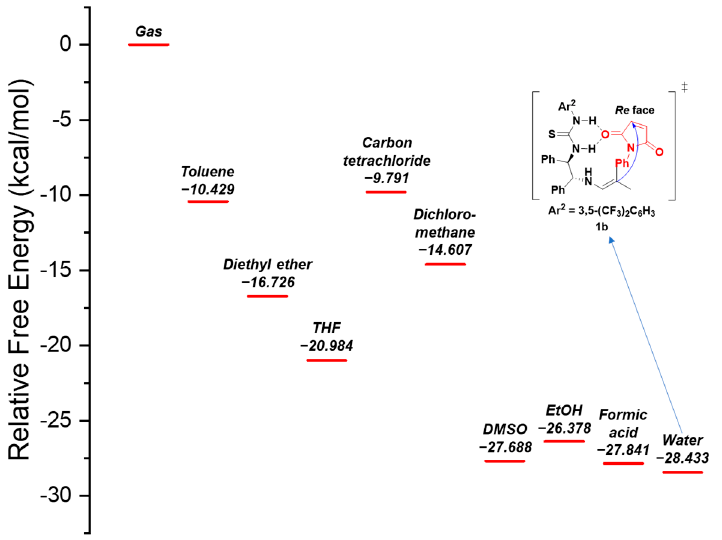
Figure 5. Proposed catalytic transition states based on B3LYP/6-31G (d, p) for the solvent + 5H 2 O condition calculations and the thermal energy diagram of the ( R , R )-1,2-diphenylethylenediamine- (DPEN)–thiourea-catalyzed enantioselective Michael reaction.